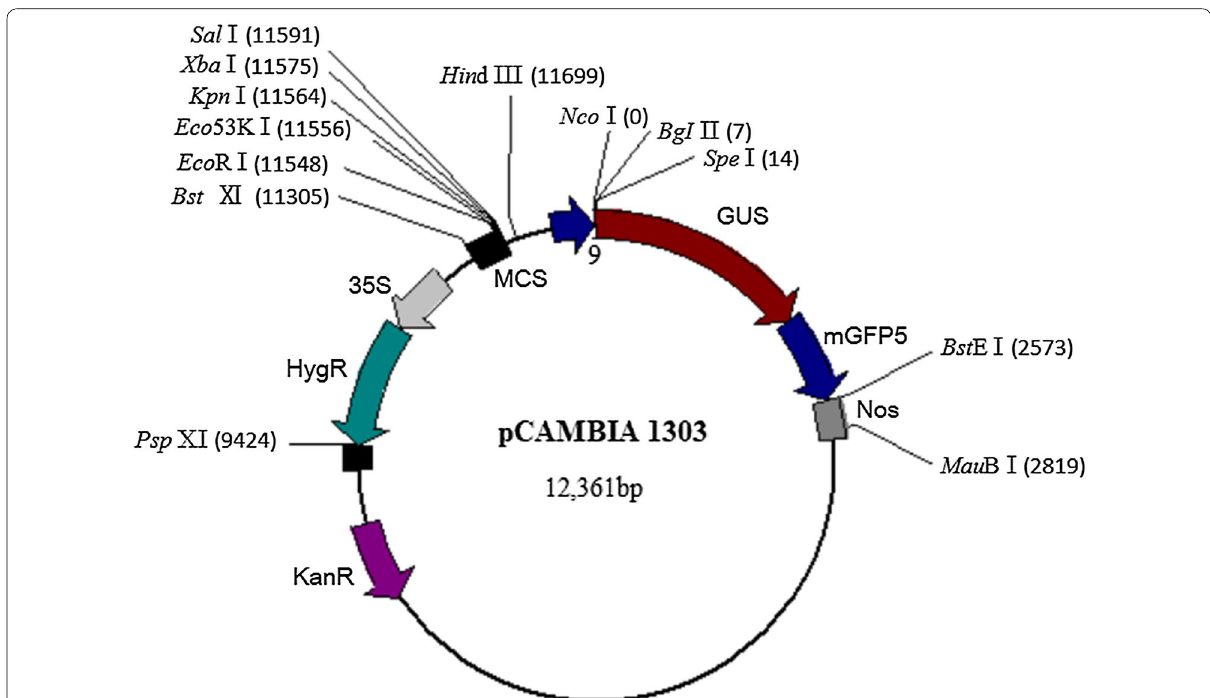
Fig. 1 35S CaMV 35S promoter, GUS β-glucuronidase, mGFP5 modified green fluorescent protein, Nos nos terminator. Restriction endonuclease sites are